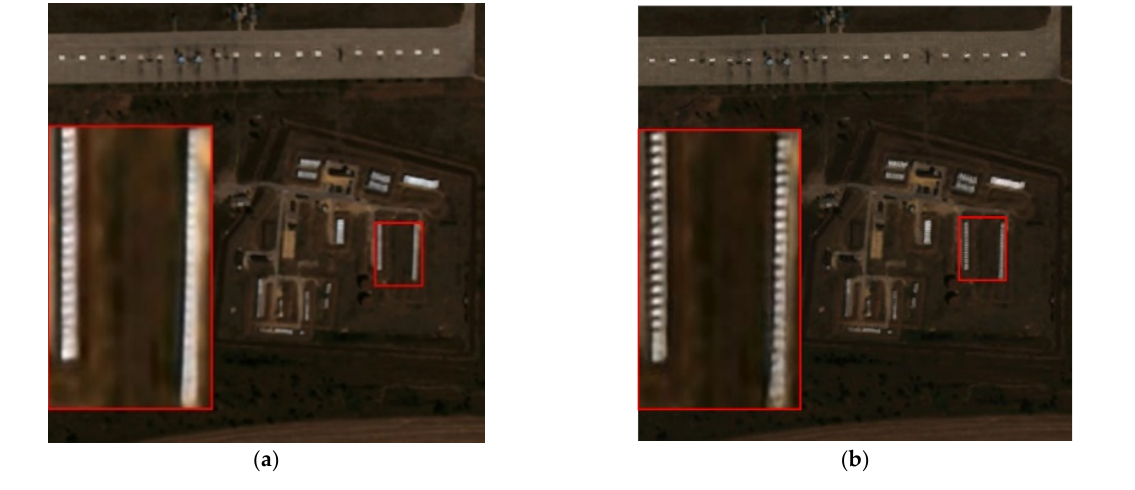
Figure 9. Visual comparison for high-frequency details of images fused by the U-Net (Figure 9 ( a )) and HRNet backbones (Figure 9 ( b )). For this experiment we choose Experiment 1 with 6×. The large red box contains the zoomed-in region in the small box.